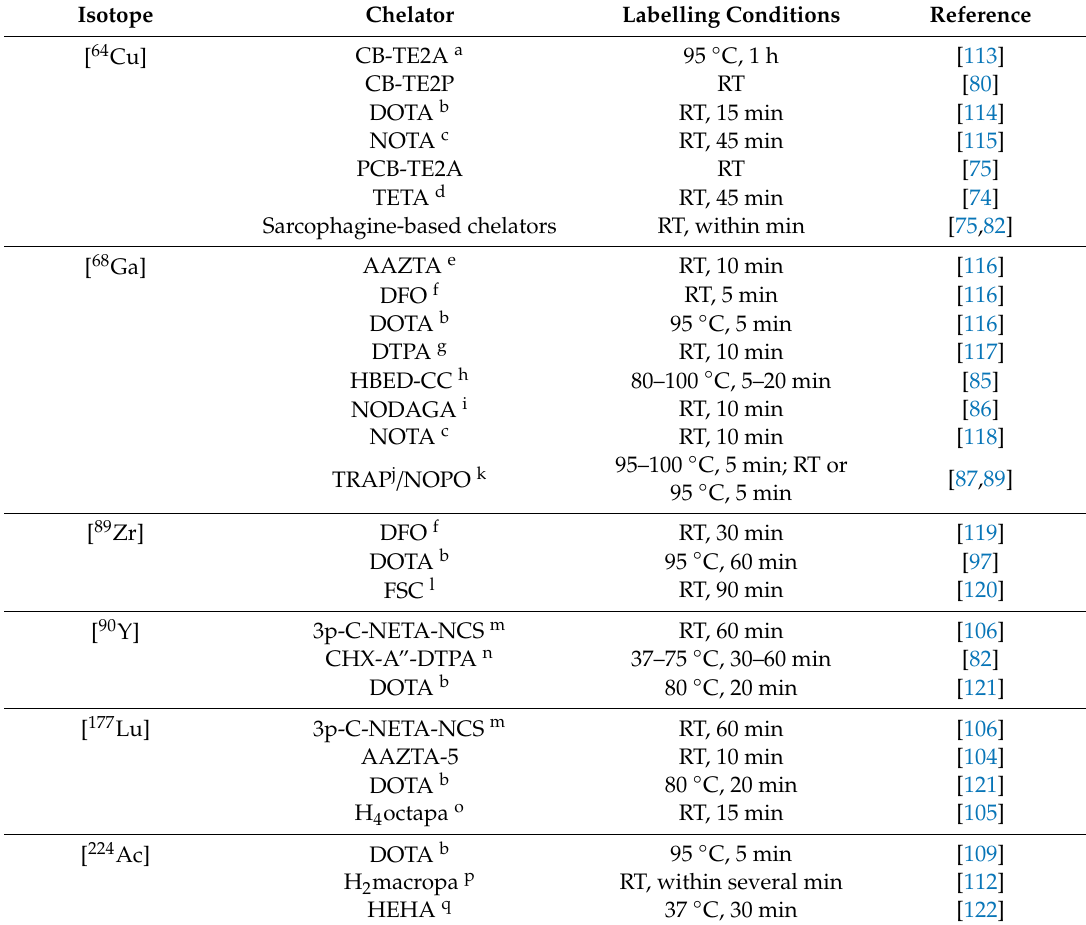
Table 2. Summary of chelators for the di ff erent radioactive isotopes and published labelling conditions (reaction temperature and incubation